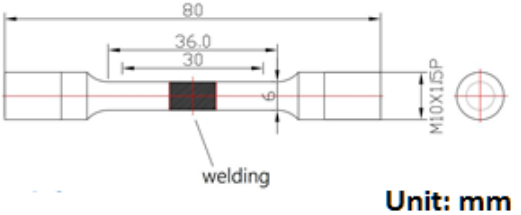
Figure 5. Configuration of tensile test specimen (ASTM E8M).